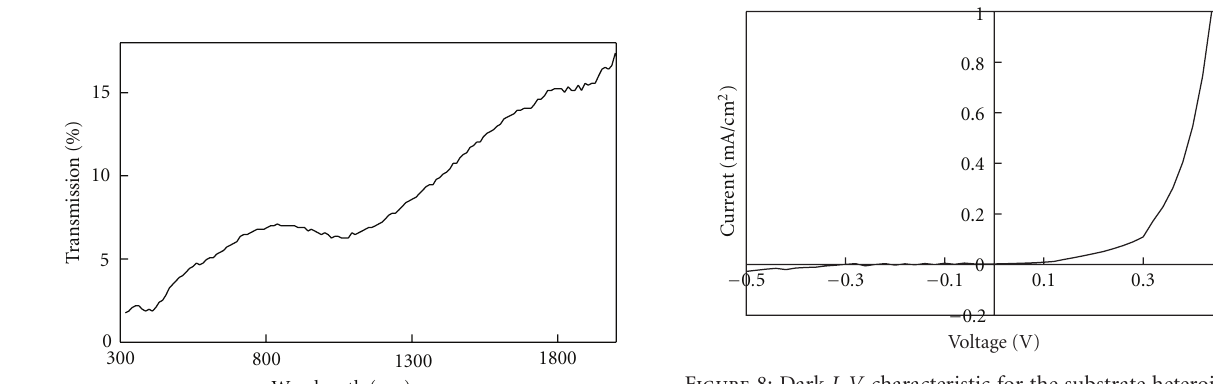
Figure 8: Dark I - V characteristic for the substrate heterojunction with the 30-min-deposited CTSO film (condition